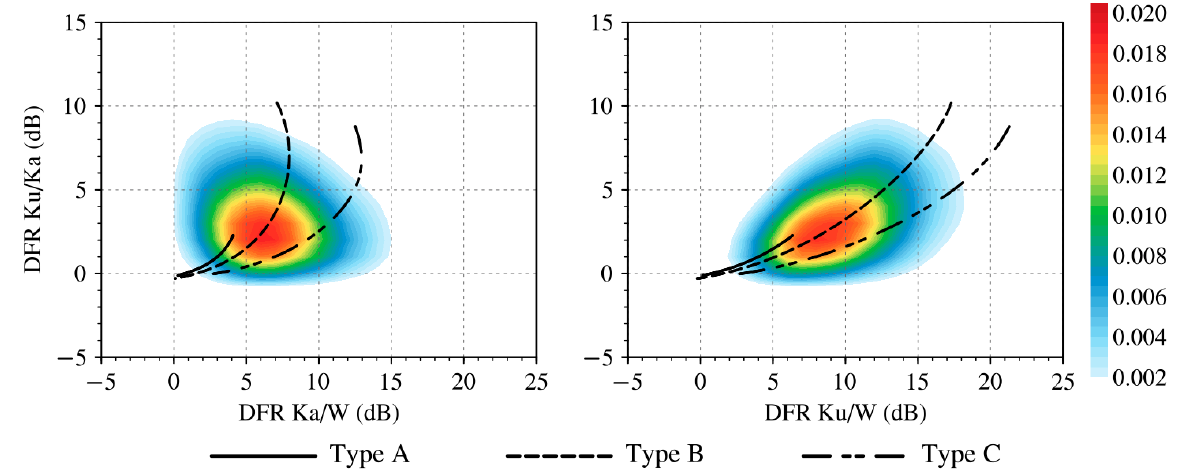
Figure 4. Modeled triple-frequency signatures (lines) and normalized occurrence frequencies of observed triple-frequency signatures (shading) in 1 dB × 1 dB boxes.